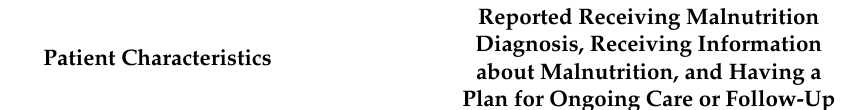
Table 4. Associations between patient characteristics and a combined measure of all patient- reported